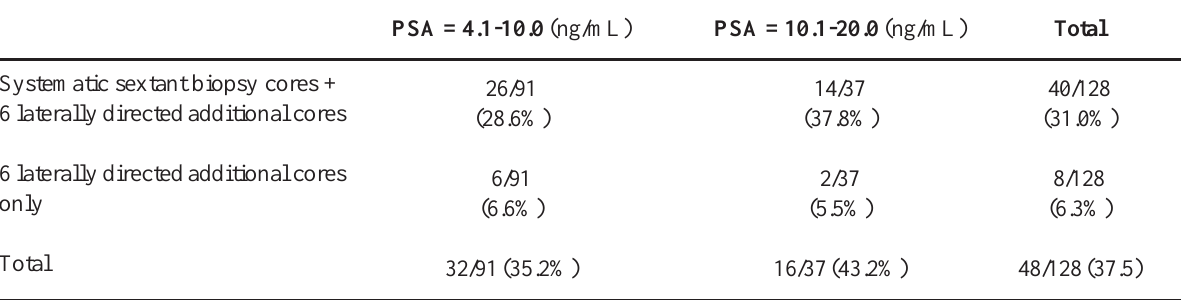
Table 3 – Diagnostic rate of prostate cancer by location in 12-core biopsy group.